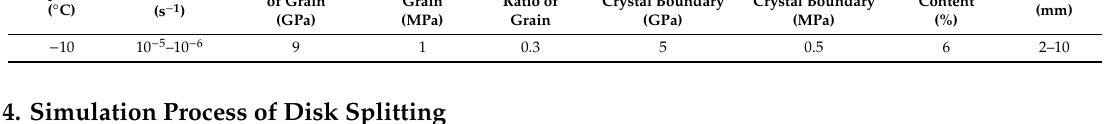
Table 1. Main parameter values of river ice in the numerical calculation.